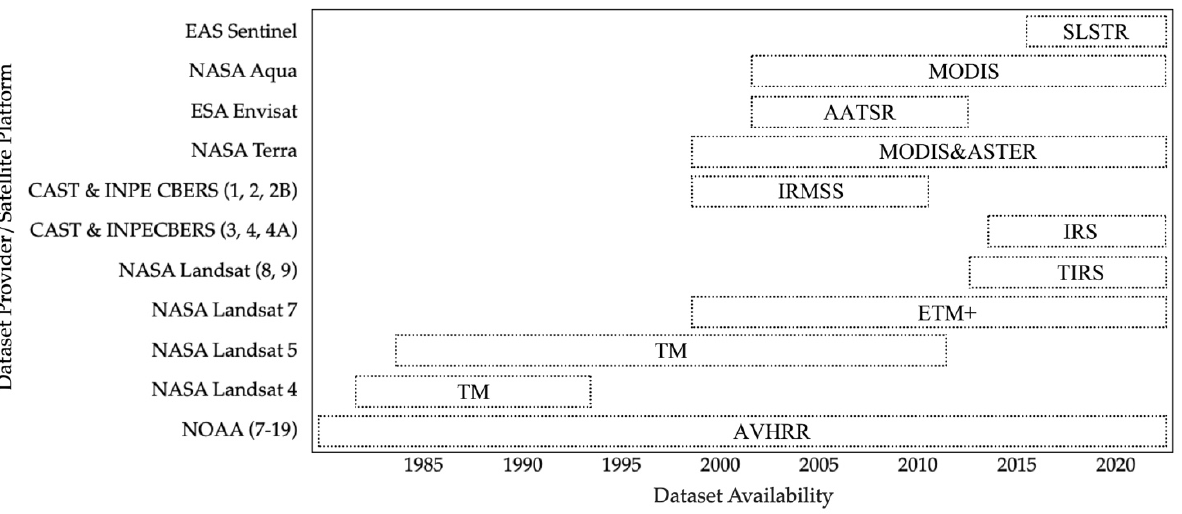
Figure 3. Timeline for the major urban thermal environment observation satellites launch and associated sensor data availability (adapted from [74,75]).